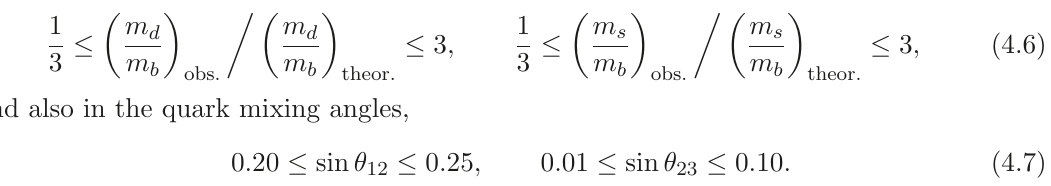
Table 3 . Sample values of an illustrating parameter configuration in Pattern IV as an example. Observed values are also quoted from ref. [44]. Input parameters are chosen as Re τ = 0 . 5, Im τ = 1 . 7, ρ u = 0 . 26, ρ d = 0 . 19 and ρ ′ d = 0 . 012. also in the down-quark